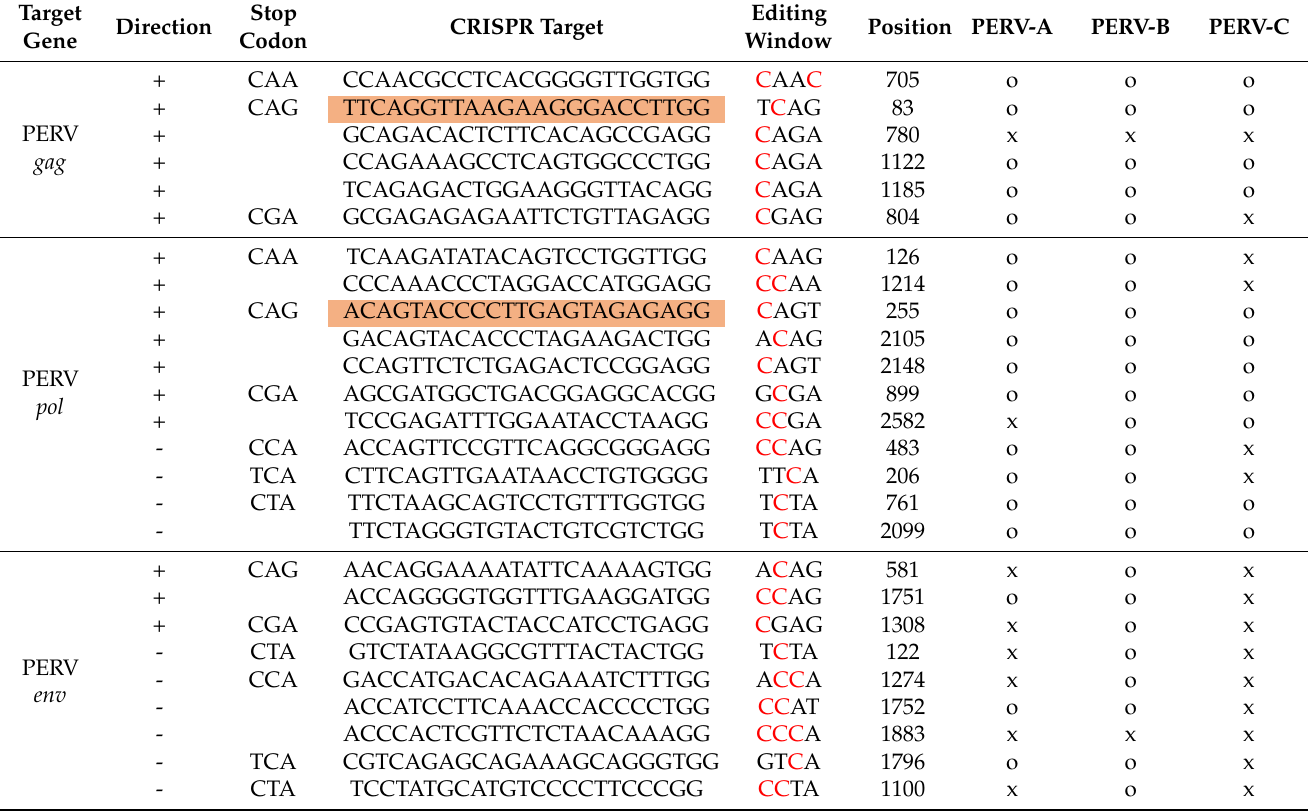
Table 1. Design of target gRNA sequences used in the study. Among the potential targets, the orange-highlighted gRNAs were selected for use in this study. PERV = porcine endogenous retrovirus. Cytosines in Editing Window marked in red letters indicate target sequences of